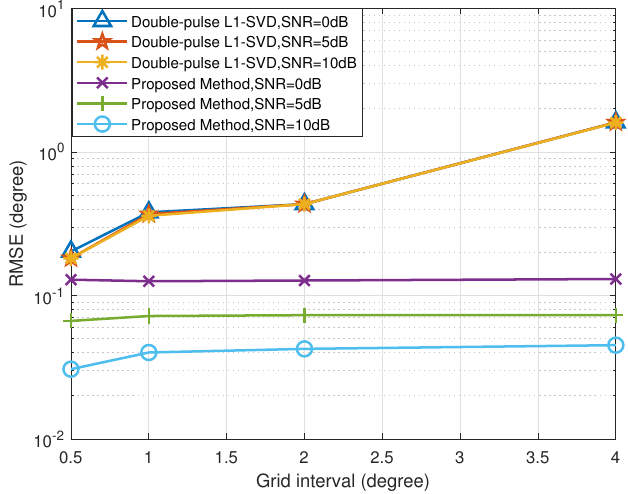
Figure 7. RMSE of DOA estimation versus grid interval.